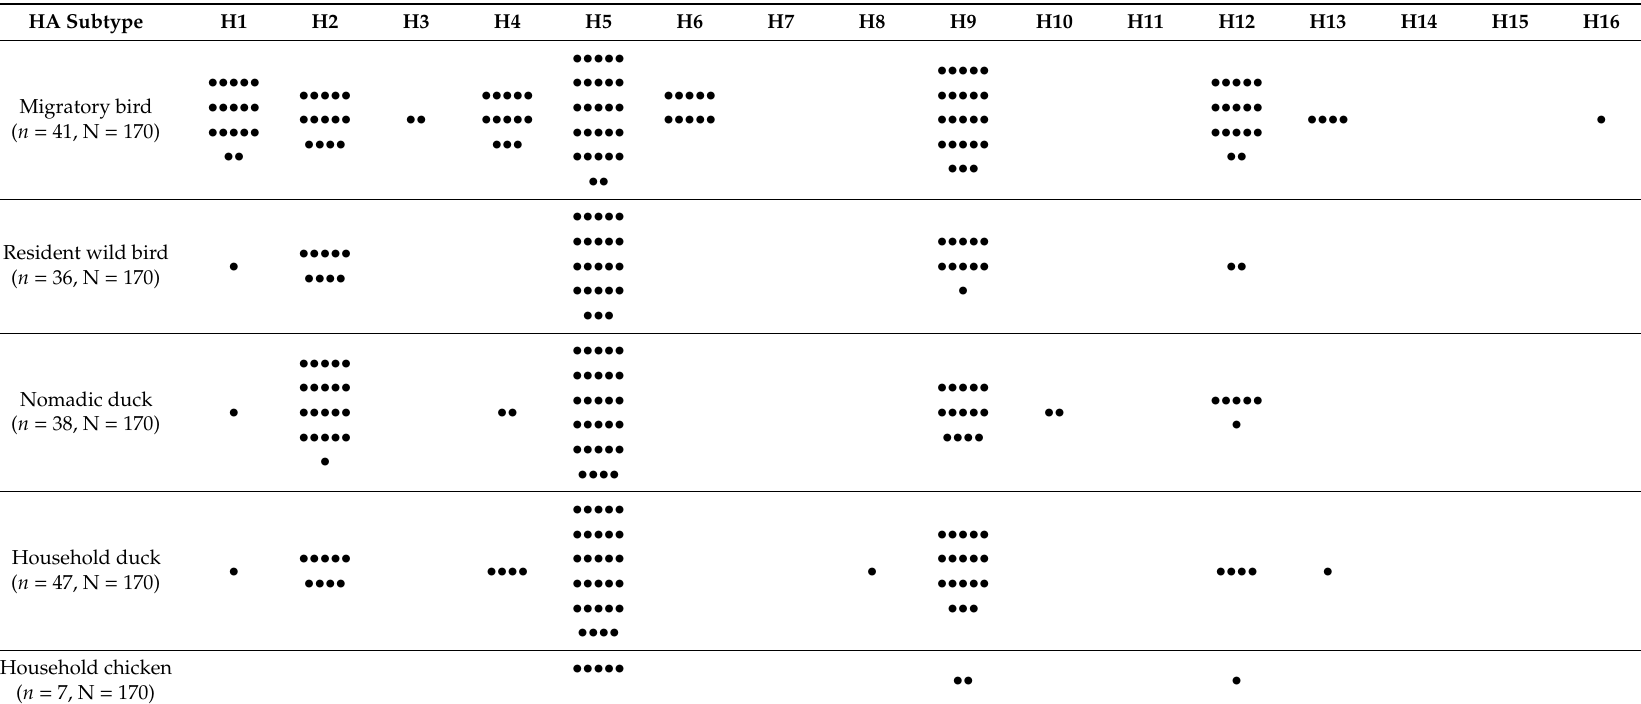
Table 1. Matrix of bird type and avian influenza haemagglutinin (HA) serotype in